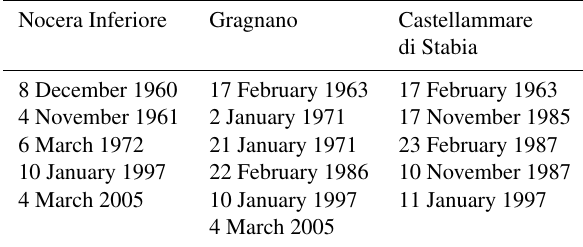
Table 2. Flow-like mass movements affecting pyroclastic covers in Nocera Inferiore, Gragnano, and Castellammare di Stabia in the pe- riod